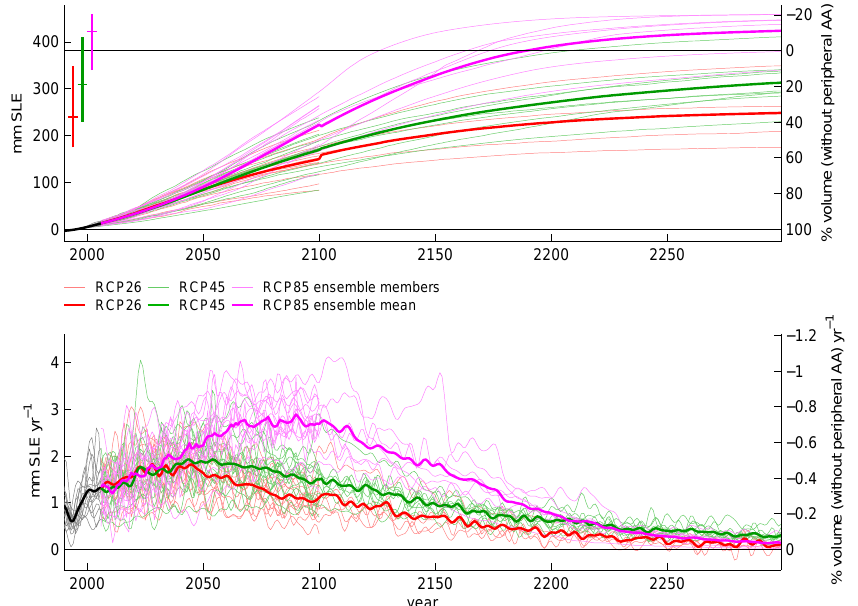
Fig. 24. Cumulative global surface mass balances relative to the 1986–2005 mean (upper panel), and rates (lower panel) from the model forced with CMIP5 projections, up to the year 2300. Light colored lines: model forced by individual CMIP5 ensemble members, solid lines: means of light colored lines. Crosses on the left (upper panel) indicate mean and range of ensemble for each RCP scenario in the year 2300. Rates have been filtered with a 5yr low pass filter for